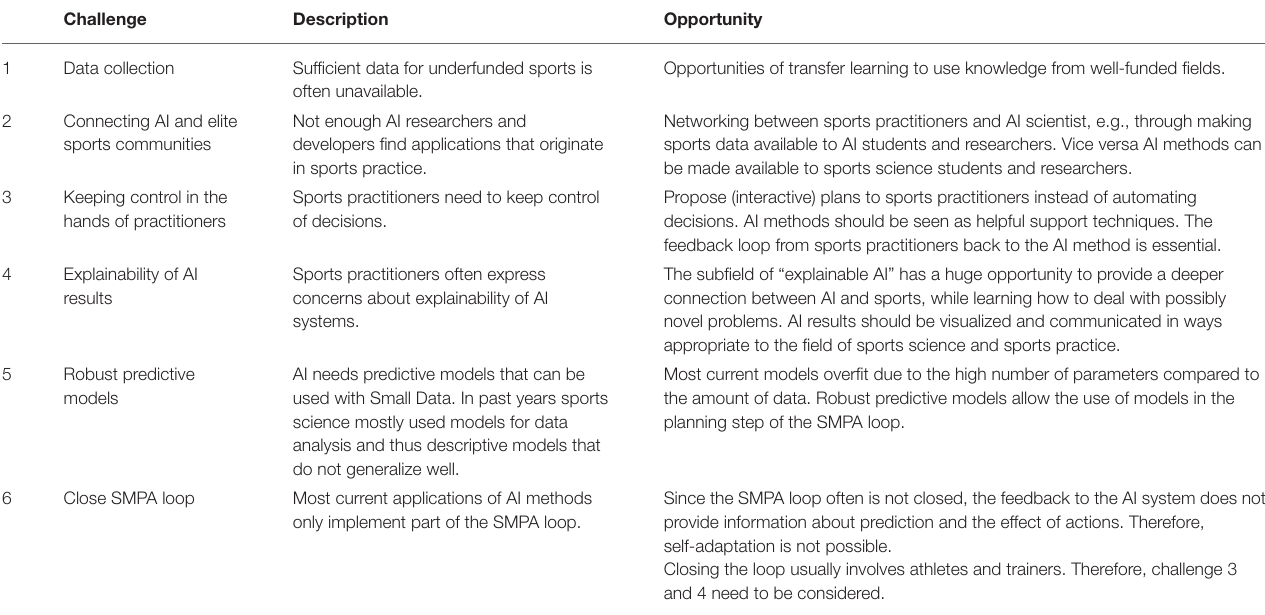
TABLE 1 | Challenges within elite sports with associated